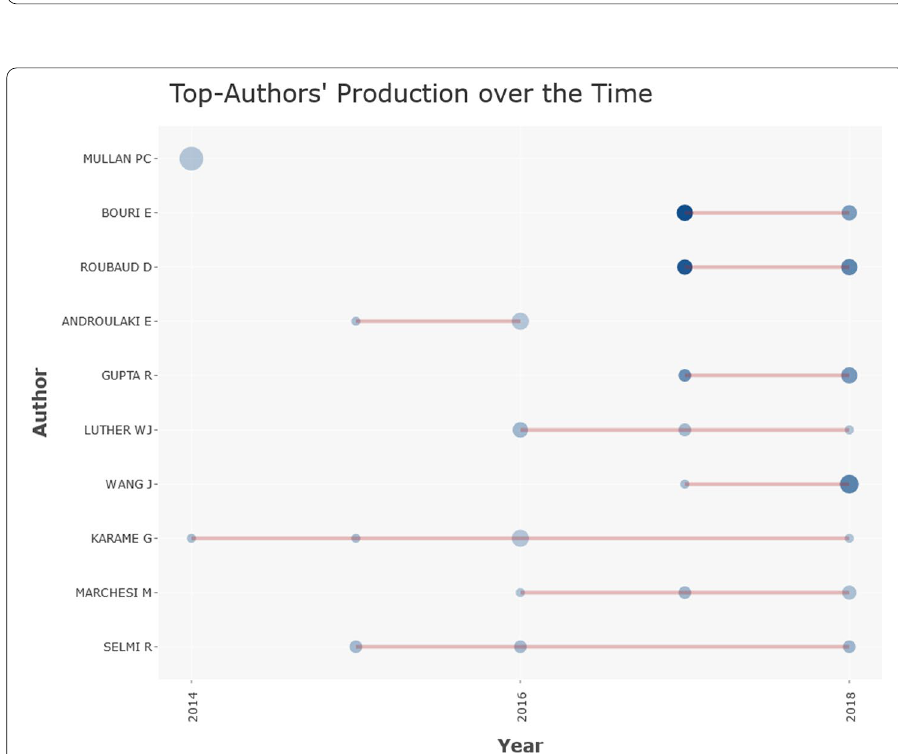
Fig. 9 Top authors’ production. Source : Own